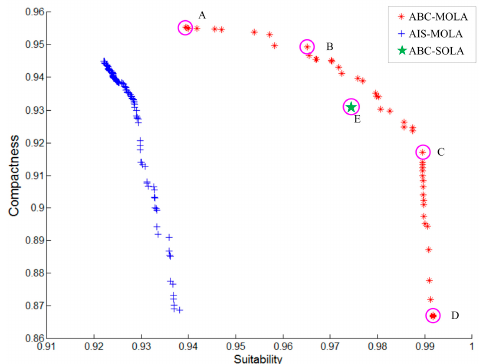
Figure 12. The Pareto fronts of ABC-MOLA and AIS-MOLA [28], and ABC-SOLA [33] solution in Jixian land-use optimization.